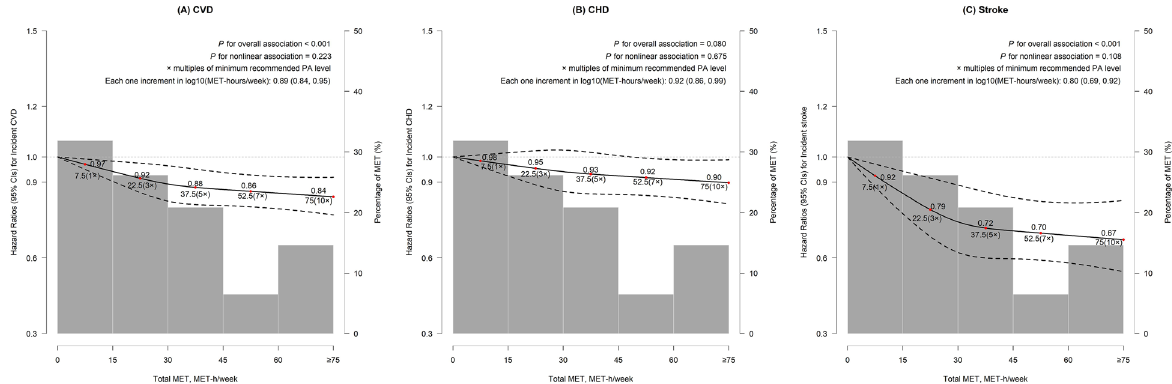
Figure 1. Adjusted hazard ratios for CVD, stroke and CHD according to levels of leisure-time physical activity. ( A ) Association between leisure-time physical activity and incident CVD. ( B ) Association between leisure-time physical activity and incident CHD. ( C ) Association between leisure-time physical activity and incident stroke. The multivariable models were adjusted for age, sex, education, smoking status, alcohol intake, consumption of food (meat, vegetables, and fruit), hypertension, hyperlipidemia, diabetes, BMI, total sedentary time, and family history of